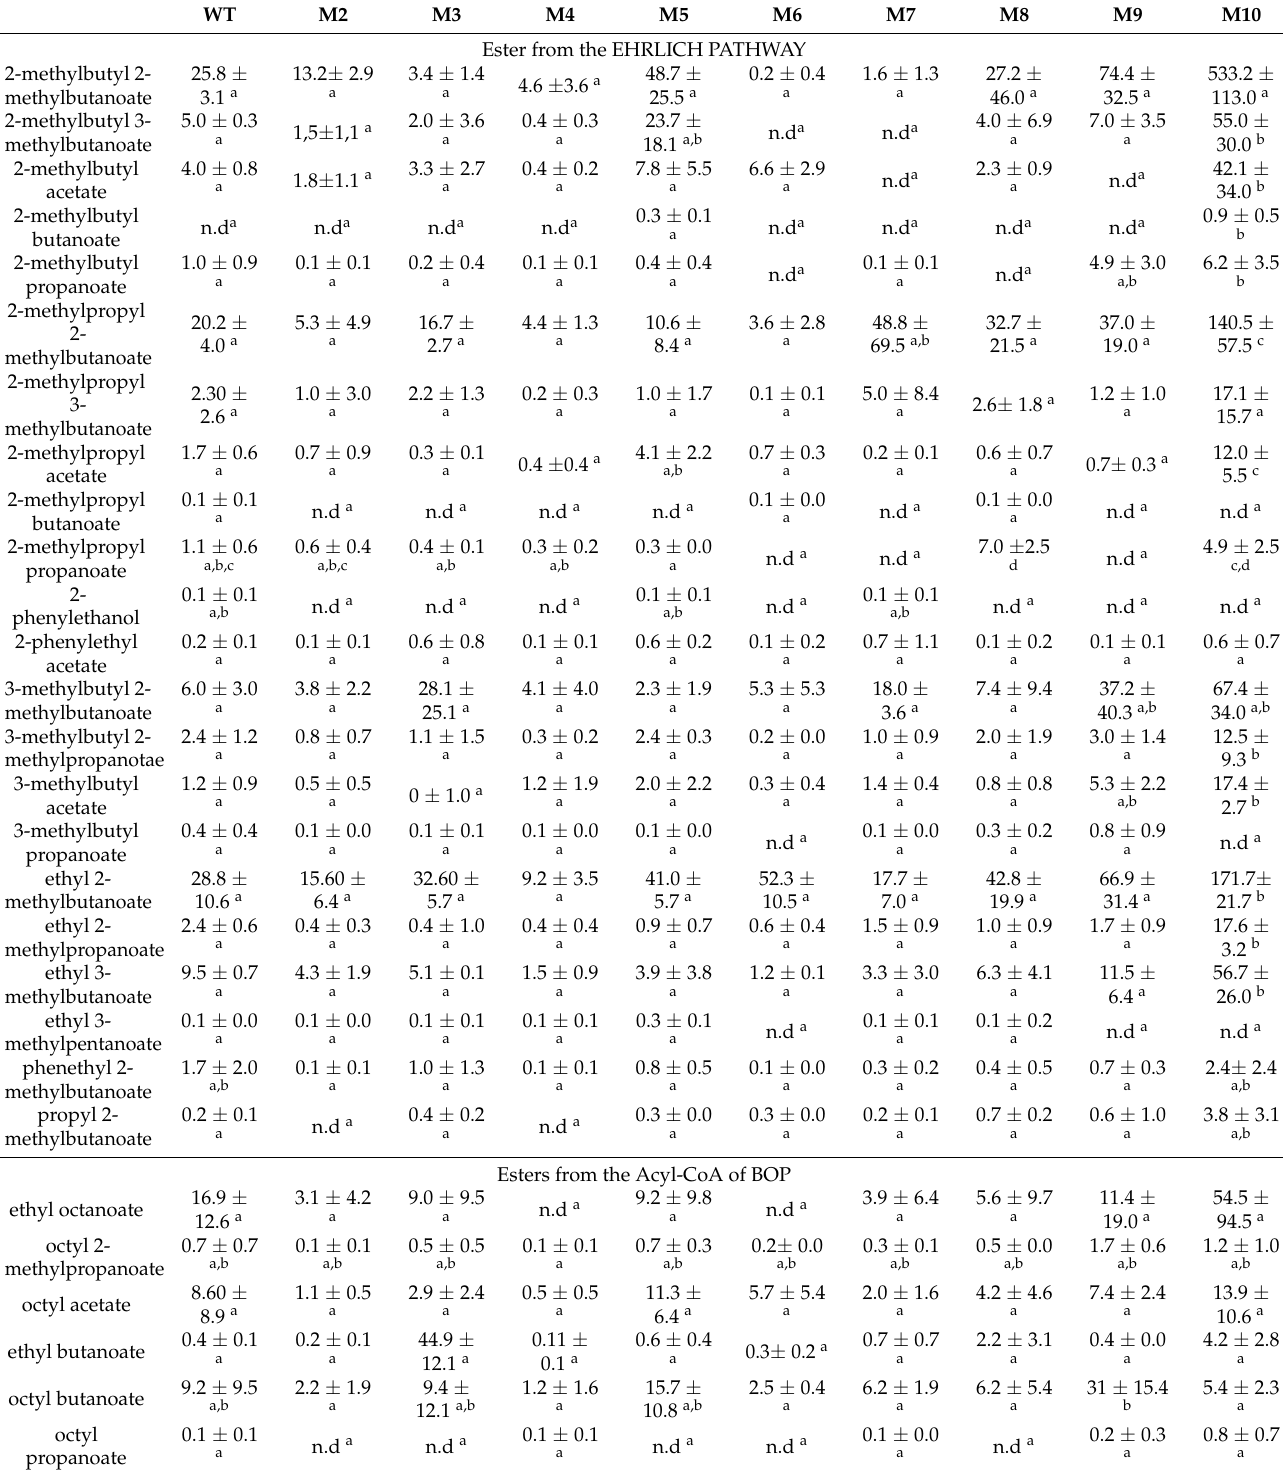
Table 2. Classification and quantification of VOCs according to pathway production in the wild-type of S. suaveolens and its 9 ILV-